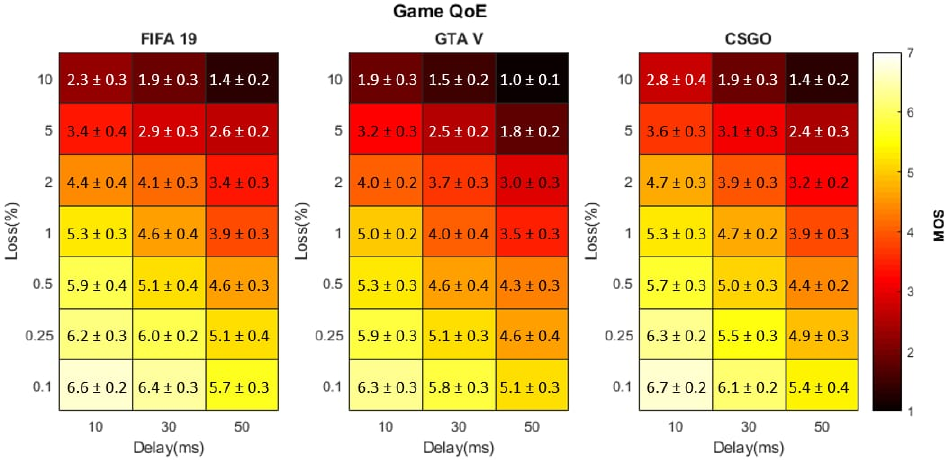
Figure 9. Heatmap of GP-QoE (MOS with Confidence Intervals) for mixed network